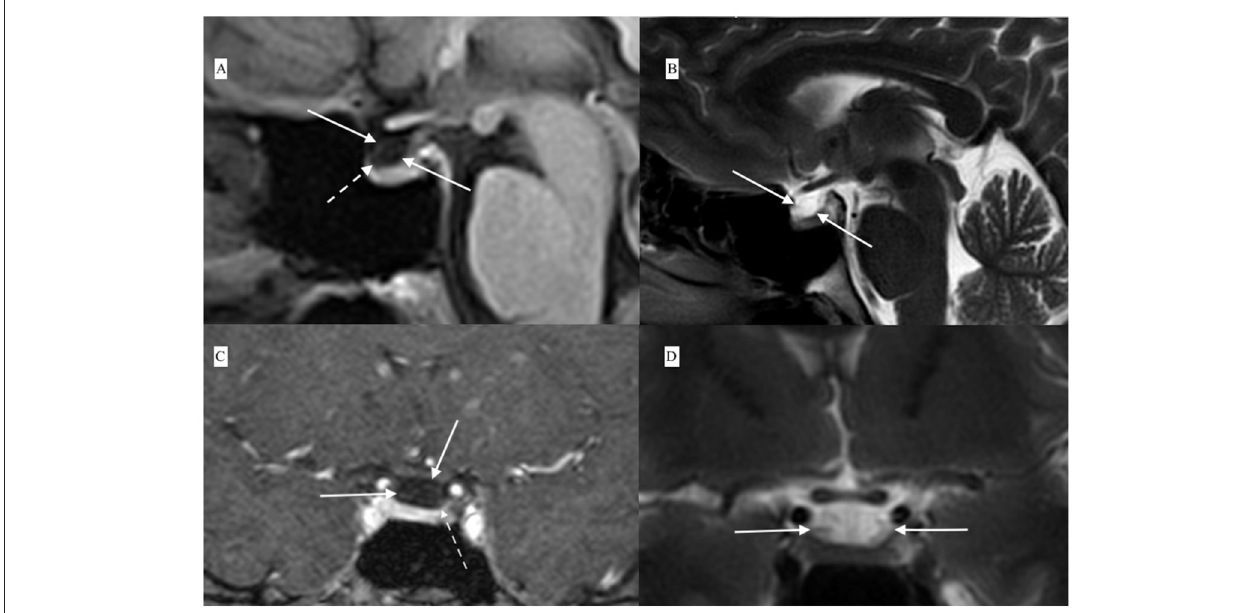
FIGURE 2 | Contrast-enhanced MRI showing Rathke’s cleft cyst (white solid arrows) anterior to the pituitary stalk and compressing the upper part of the pituitary: (A) T1-weighted contrast-enhanced sagital view, (B) T2-weighted sagital view, (C) T1-weighted contrast-enhanced coronal view, and (D) T2-weighted coronal view. Contrast enhancement of the lower part of the cyst wall in continuity with the pituitary tissue is visible in contrast-enhanced T1-weighted scans [dashed arrows in (A,C)